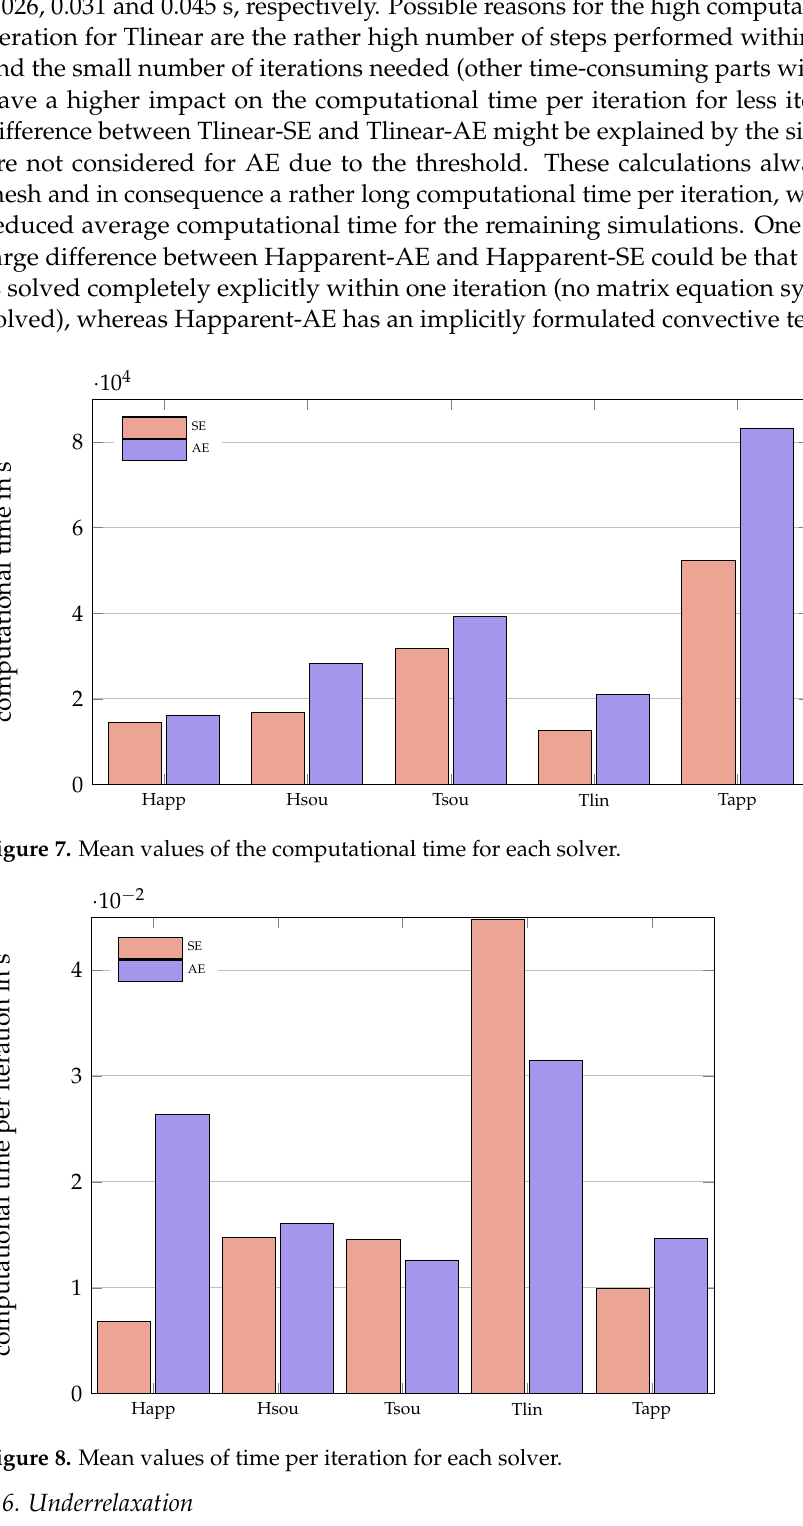
Figure 8. Mean values of time per iteration for each